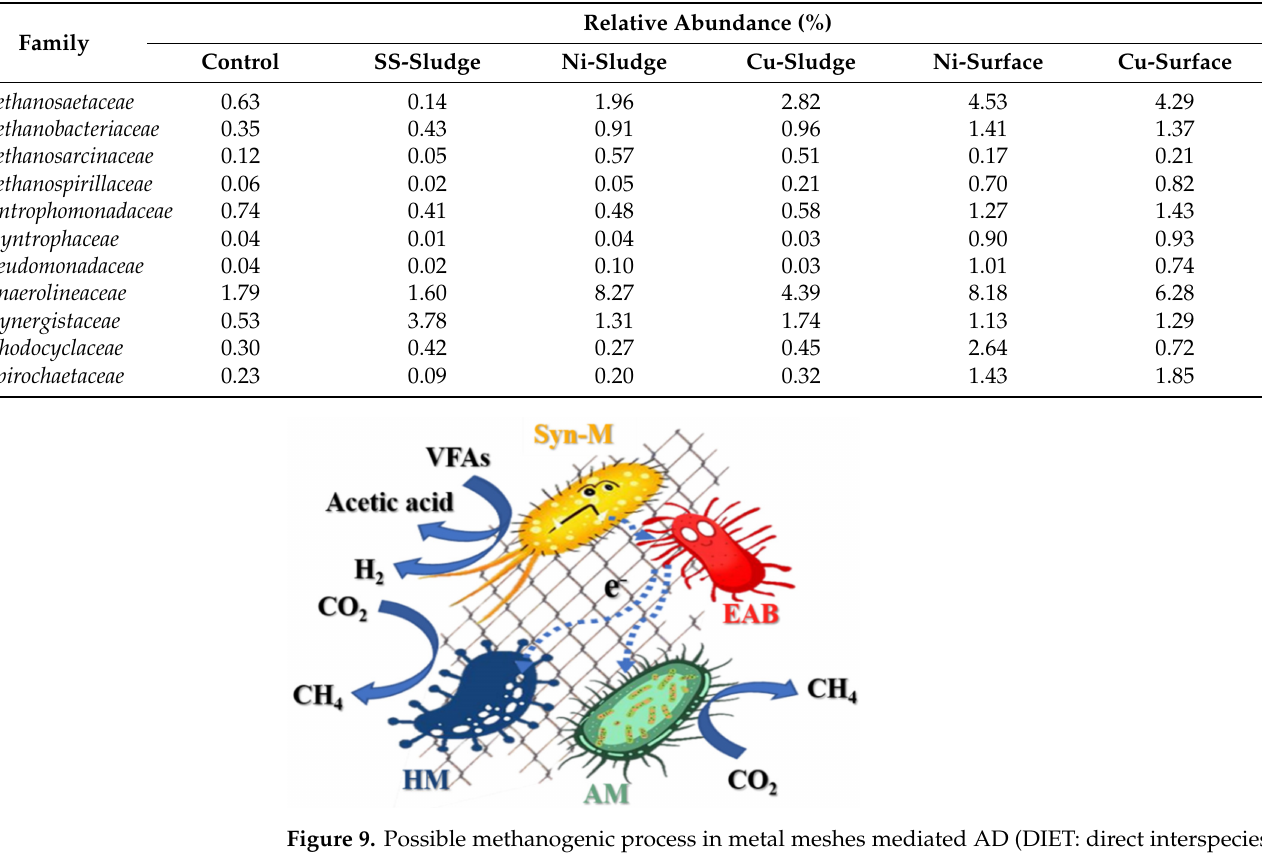
Table 1. Possible microorganisms that participate in the DIET process on metal surface.